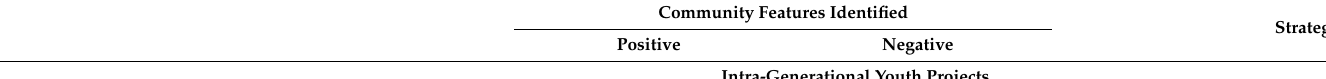
Table 1. Examples of Our Voice youth and young adult projects completed or in